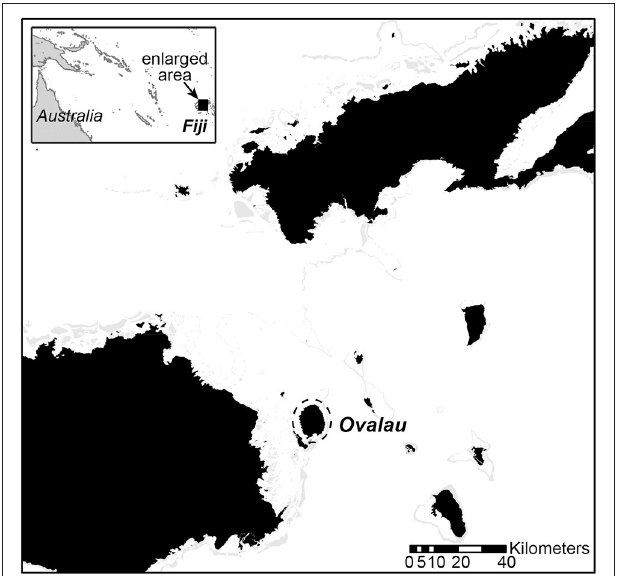
FIGURE 1 | Map of Fiji and research